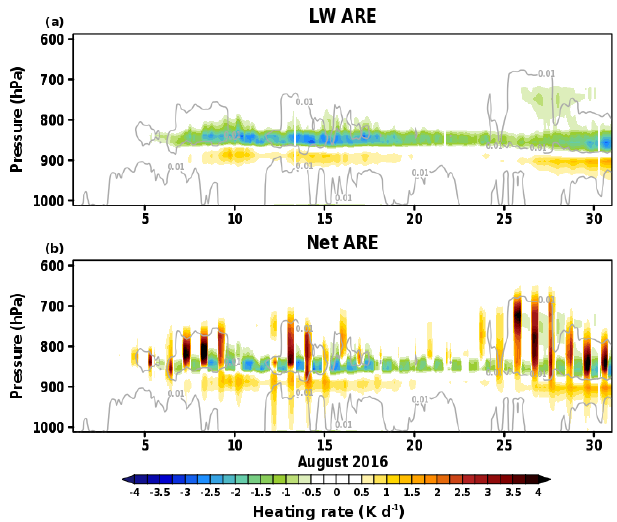
Figure 13. (a) LW cooling as a result of increased temperature from SW heating due to aerosols with the relative-humidity-scaled SSA and (b) the net heating rate due to aerosols over Ascension Island during August 2016 under clear skies. Gray contours indicate an AOD of 0.01 at